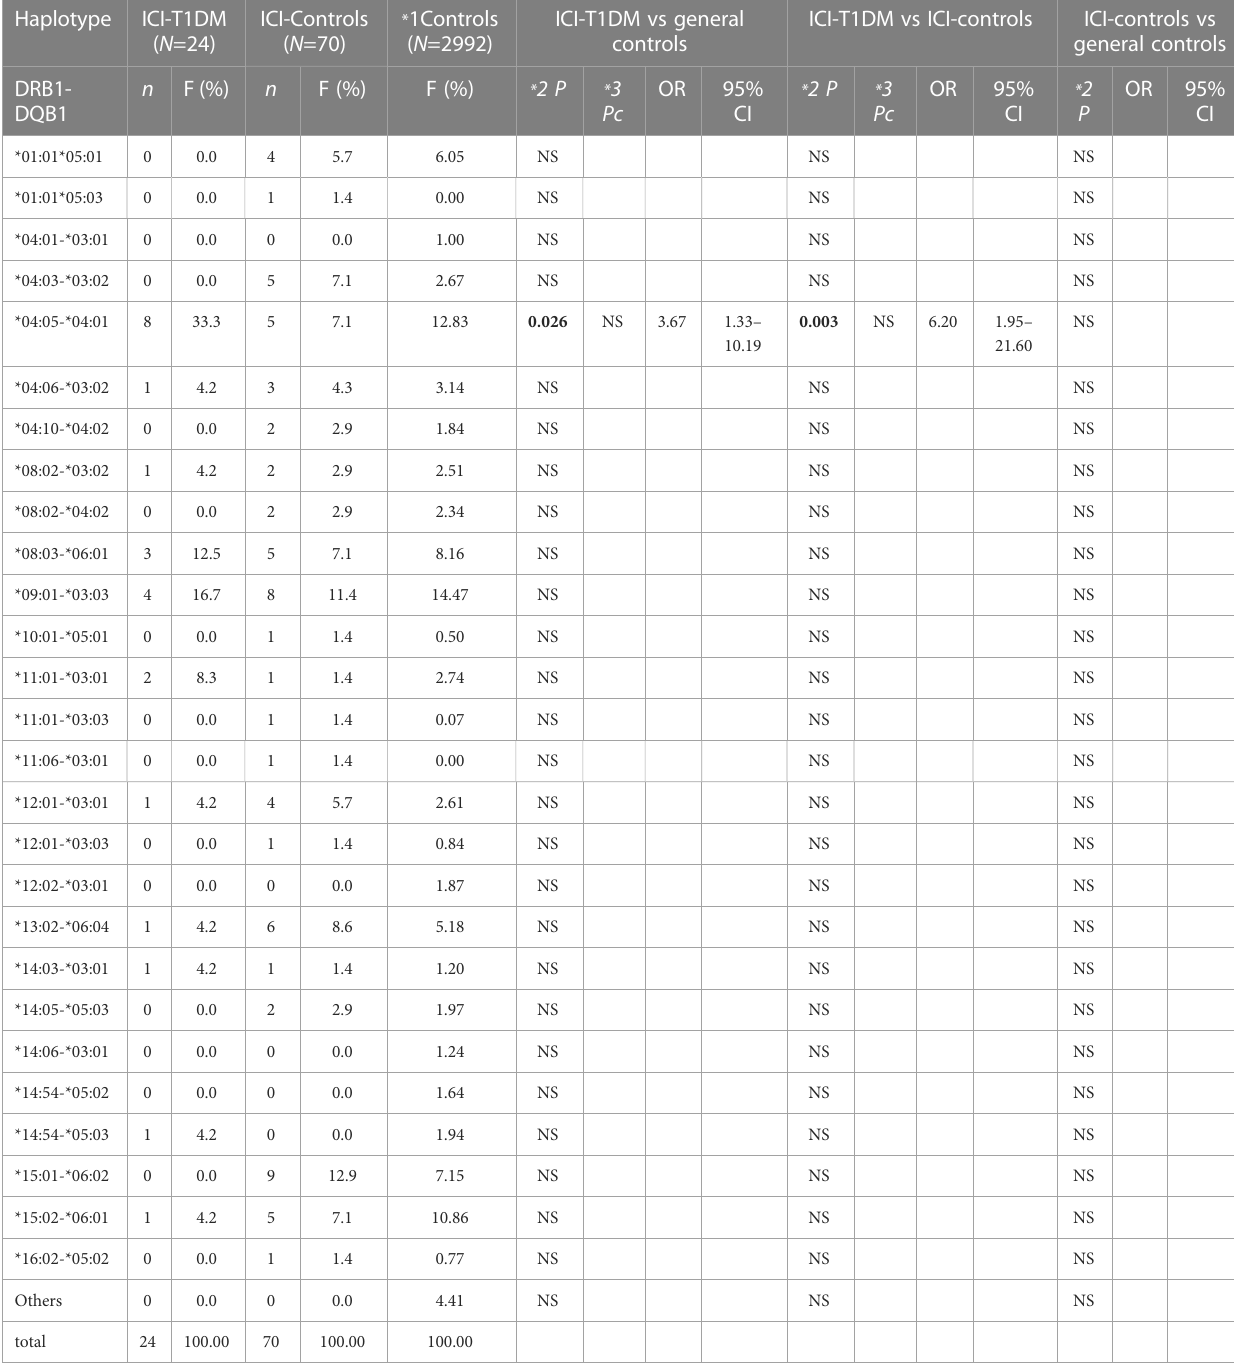
TABLE 2D Haplotype frequencies of HLA-DRB1-DQB1 in patients with ICI-T1DM. Haplotype ICI-T1DM vs general